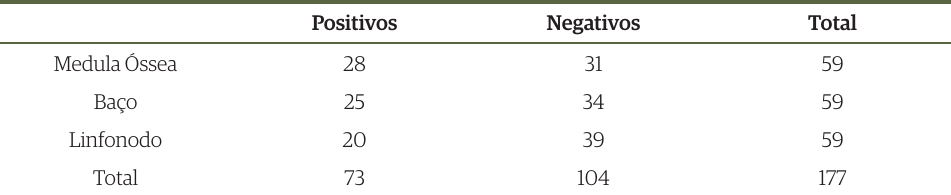
Tabela 2. Número de animais positivos e negativos de acordo com local de coleta de amostra para teste parasitológico, Uberlândia - MG, 2010.